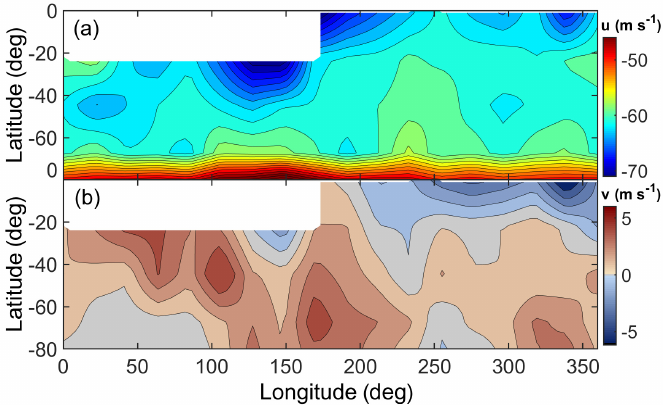
Figure 9. Longitudinal distribution of the zonal ( a ) and the meridional ( b ) wind velocities from VIRTIS-M data, indicated by isolines.